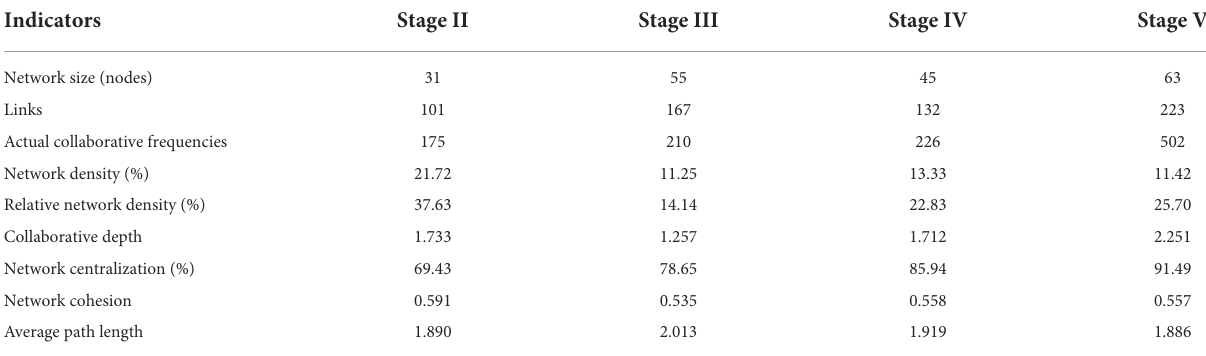
TABLE 3 Structure characteristics of